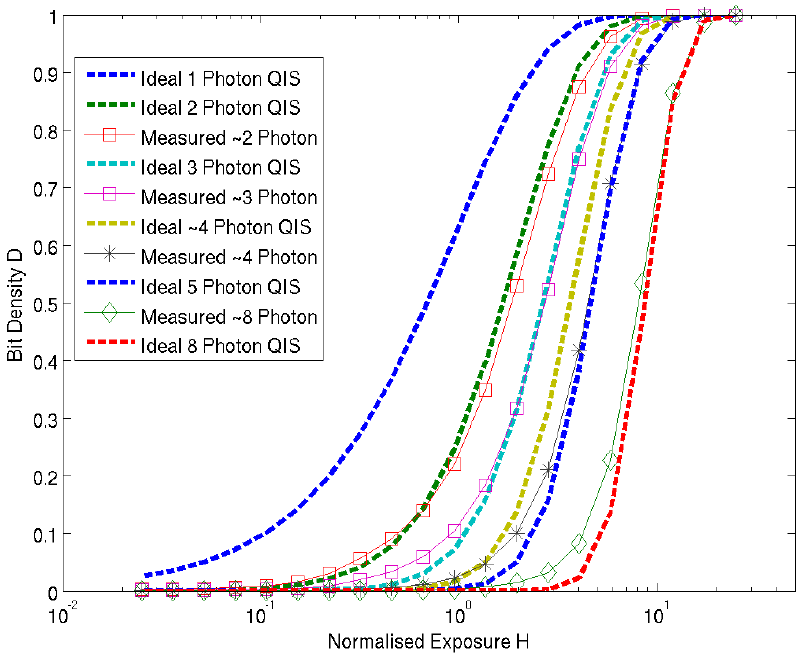
Figure 8. Multi-photon threshold oversampled binary imaging normalised bit density to exposure. Ideal curves from [9] are presented alongside measured results.